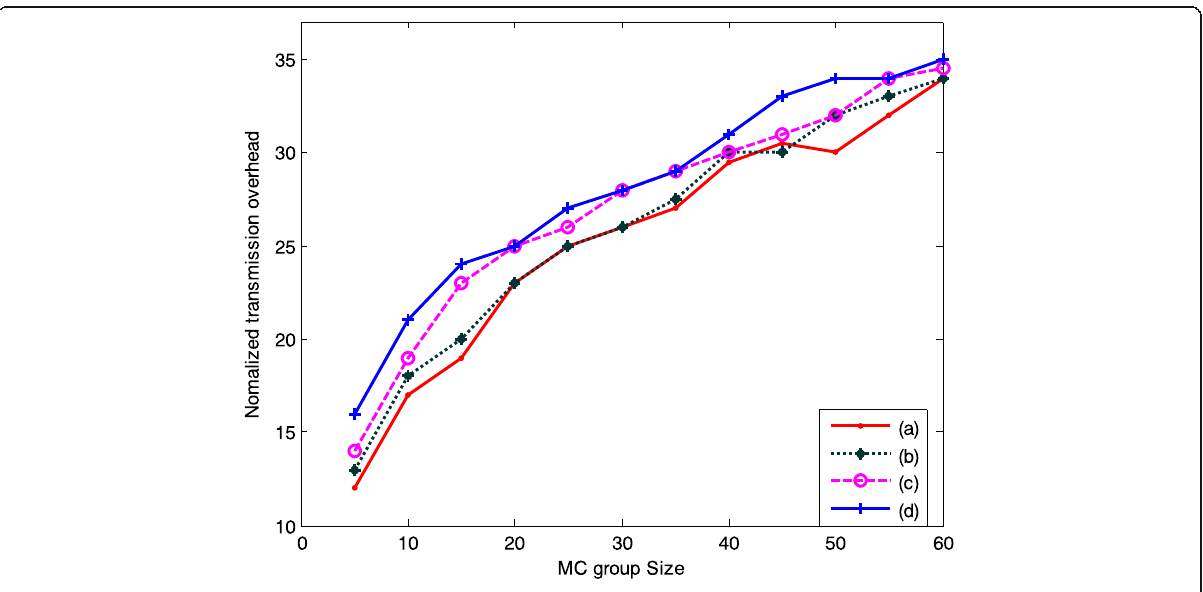
Fig. 14 Overhead comparison of normalized